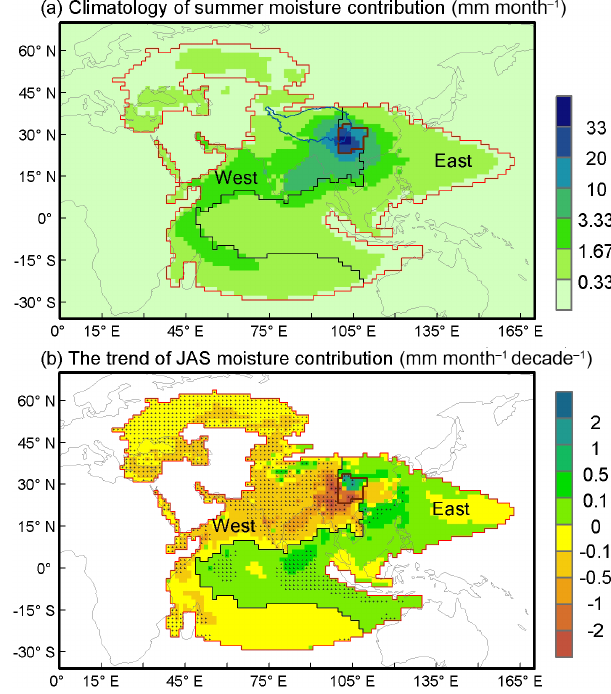
Figure 3. (a) Climatology of the July, August, and September (JAS) moisture contribution to the SWC precipitation from 1979 to 2013. The red line delineates the major source region (i.e., grids with value above 0.27mmmonth − 1 ) which contributes 88.3% of the JAS pre- cipitation moisture in SWC. The black line divides the major source region into the extended west, SWC, and extended east regions. The blue line delineates the Tibetan Plateau (Zhang et al., 2014). (b) The trend of the JAS moisture contribution from 1979 to 2013. The dots indicate a trend at the 5% significance level based on the t test. Values outside the major region are not